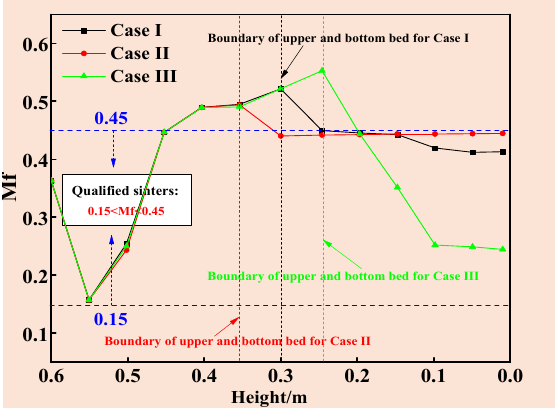
Figure 18. Mfs for cases I, II, and III at different bed heights. Table 7. Analysis of Mf for case I, II and III.